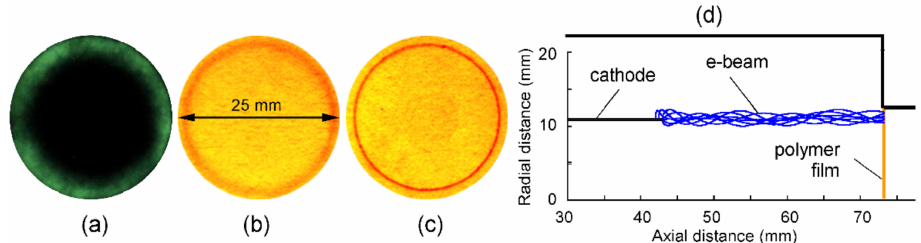
Figure 6. Autographs of tubular beams in the MICD with graphite cathode and the gap D = 30 mm. ( a ) RAEs at B = 0.53 T; ( b , c ) vacuum EEE beam at B = 0.53 T and B = 2.1 T, respectively. ( d ) Calculation of electron trajectories for the case ( b ).